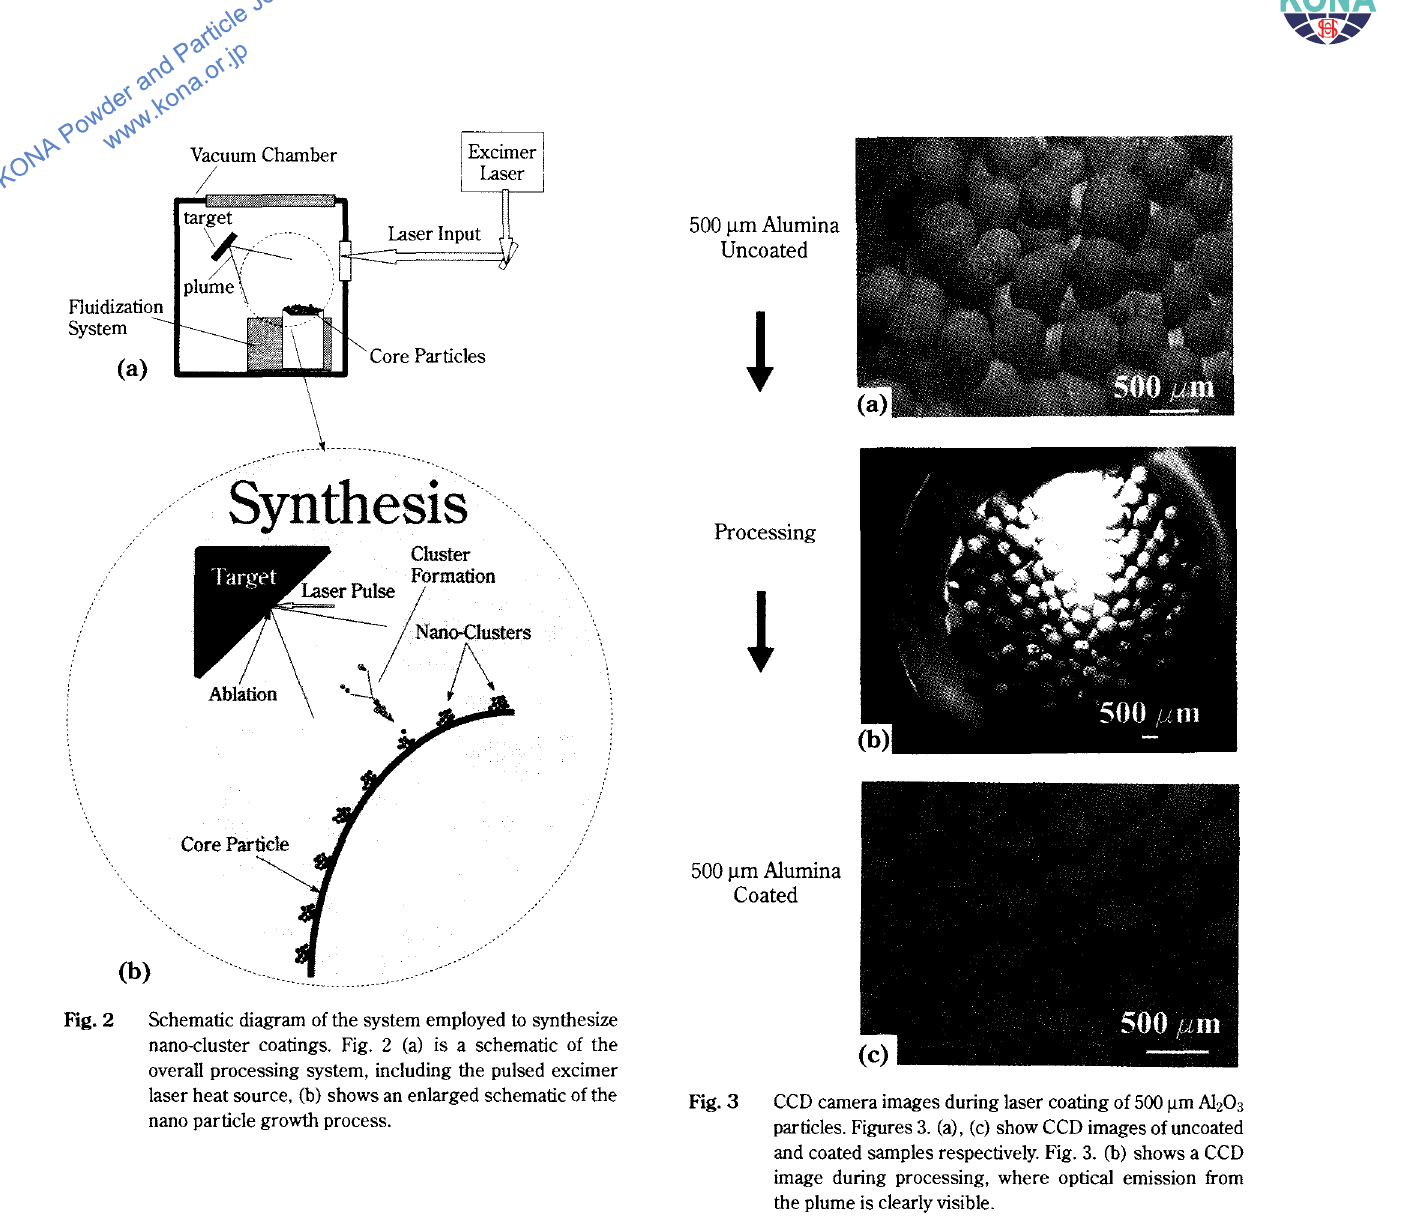
Schematic diagram of the system employed to synthesize nano-cluster coatings. Fig. 2 (a) is a schematic of the overall processing system, including the pulsed excimer laser heat source, (b) shows an enlarged schematic of the nano particle growth process.